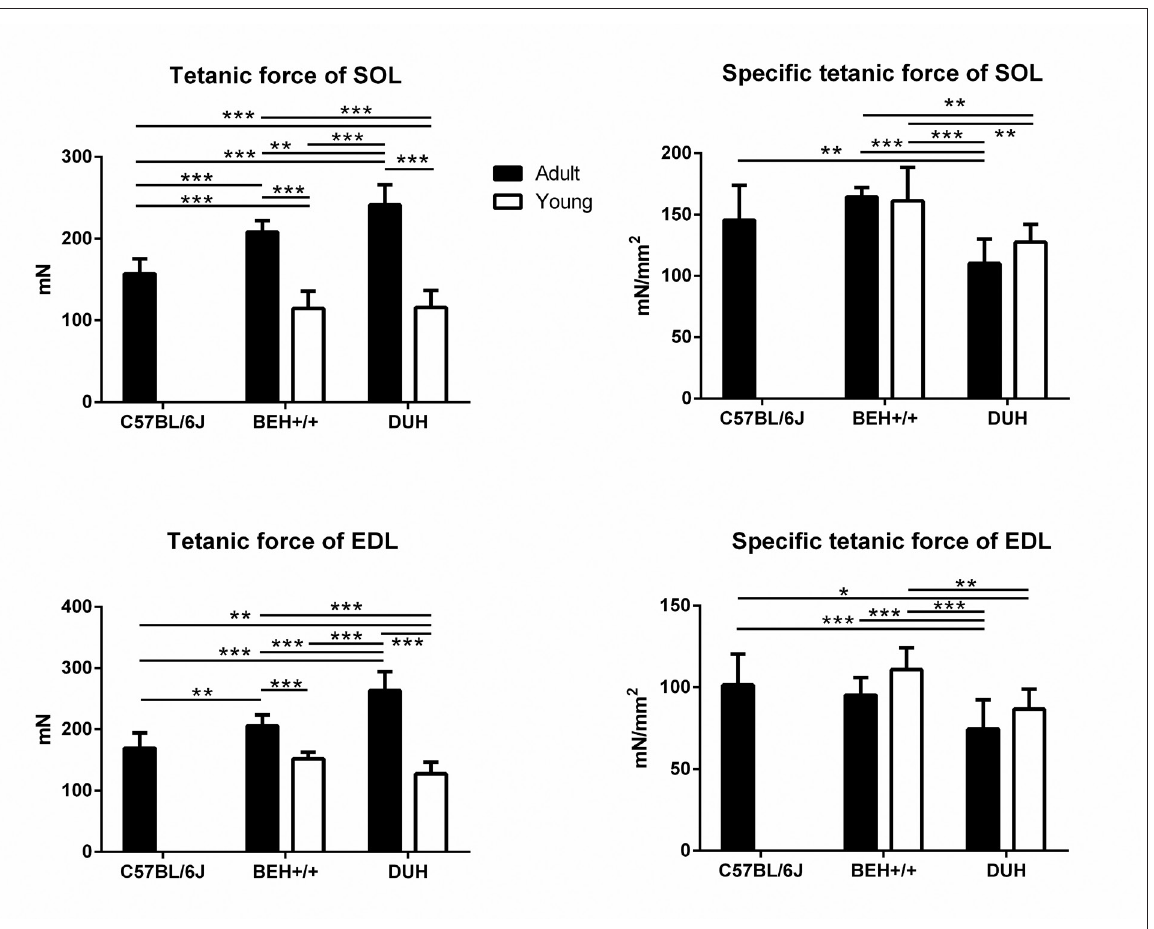
Figure 1. Tetanic force generation capacity of soleus (SOL) and extensor digitorum longus (EDL) muscles for C57BL/6J, BEH+/+ and DUH strains Note. Values are means ± SD . * p < .05, ** p < .01, *** p < .001,